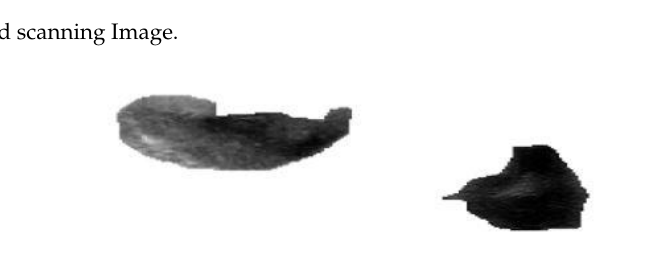
Figure 7. Segmentation process output.